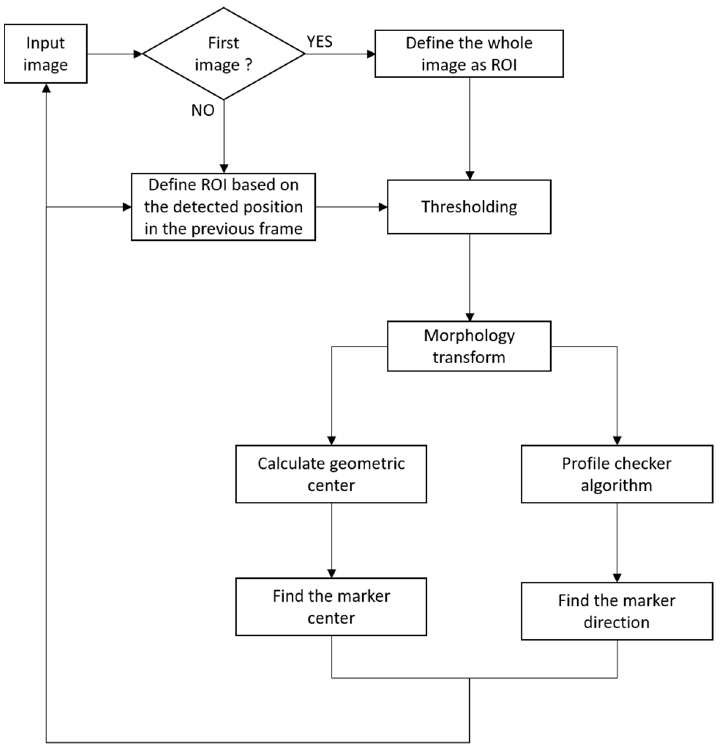
Figure 8. Flowchart of proposed marker-based tracking algorithm during night time.